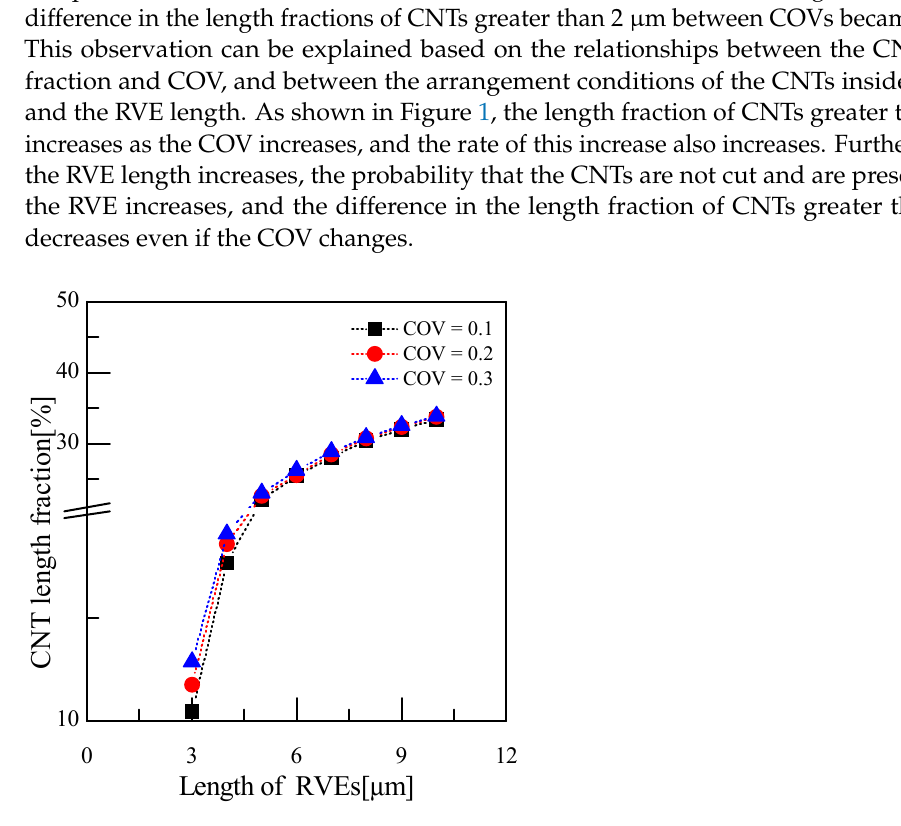
may only be achieved by ensuring that the RVE length is greater than the CNT length. In addition, because the effective properties converge to a constant value as the RVE length increases, the nanocomposite RVE must be selected considering the CNT length fraction according to the RVE